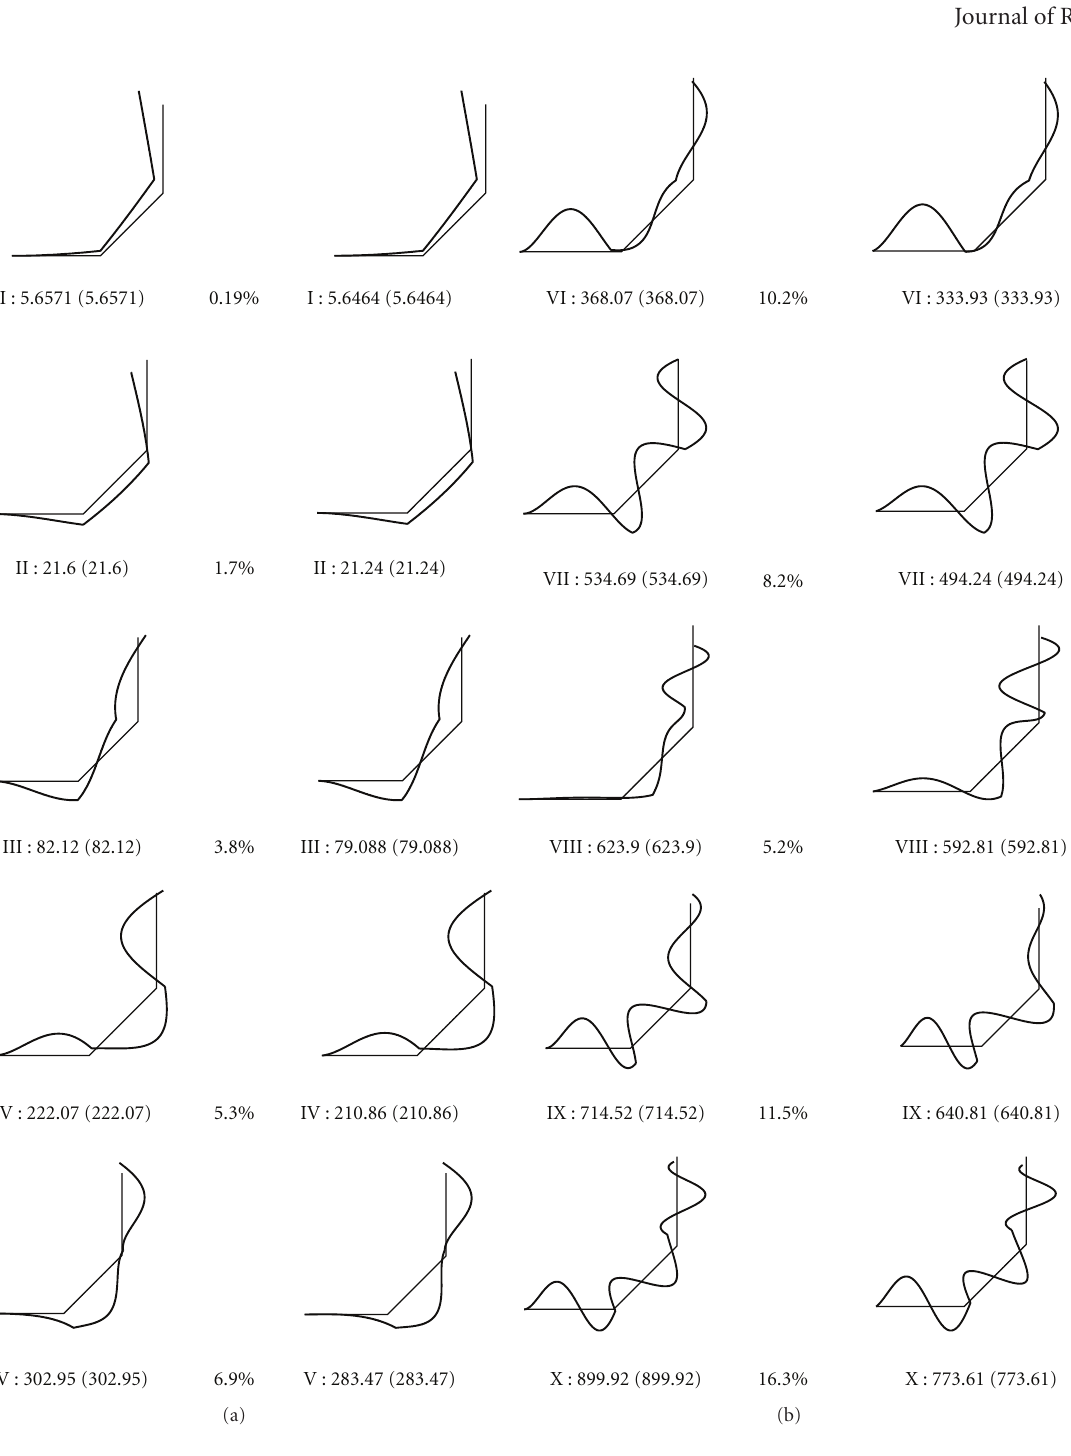
Figure 5: (a) Modes (Hz) of an industrial manipulator (see Table 8). (FEM: ABAQUS 6.6, B23, B22) left column: EB -model; right column: T -model: θ 2 = θ 3 = 45 ◦ . (b) Modes (Hz) of an industrial manipulator (see Table 8). (FEM: ABAQUS 6.6, B23, B22) left column: EB -model; right column: T -model: θ 2 = θ 3 = 45 ◦